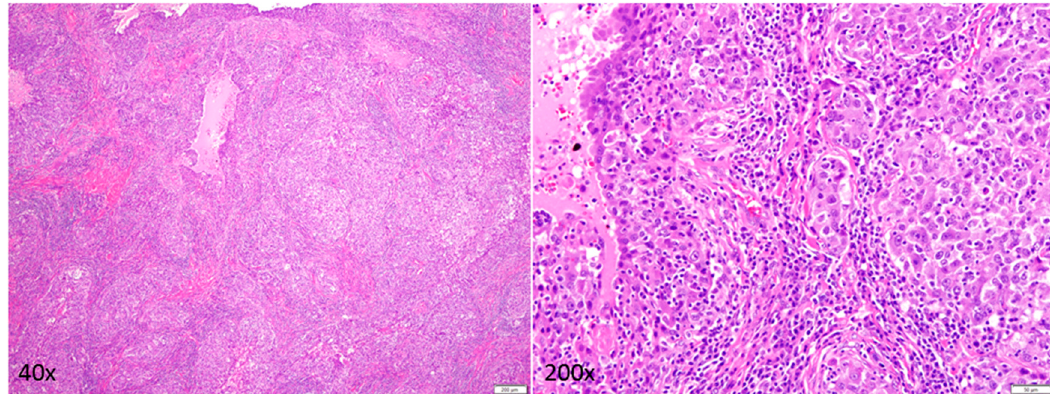
Figure 3. Photomicrograph of H&E stained invasive breast carcinoma (magnification ×40 and magnification ×200): The tumor is composed of large irregular to rounded nests of cells with pleomorphic nuclei and hyperchromasia. Mitoses and dense lymphoplasmacytic infiltration are observed.